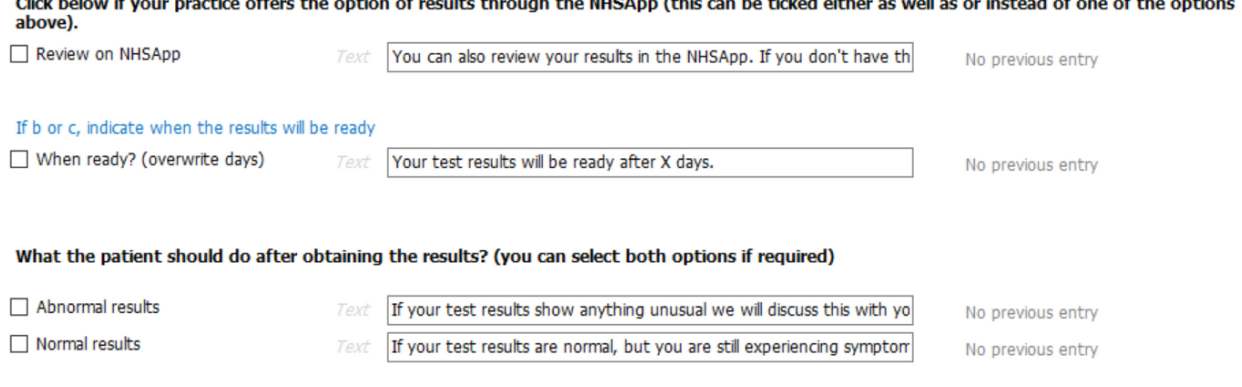
Figure 8. Summary report EMIS template – test requested section